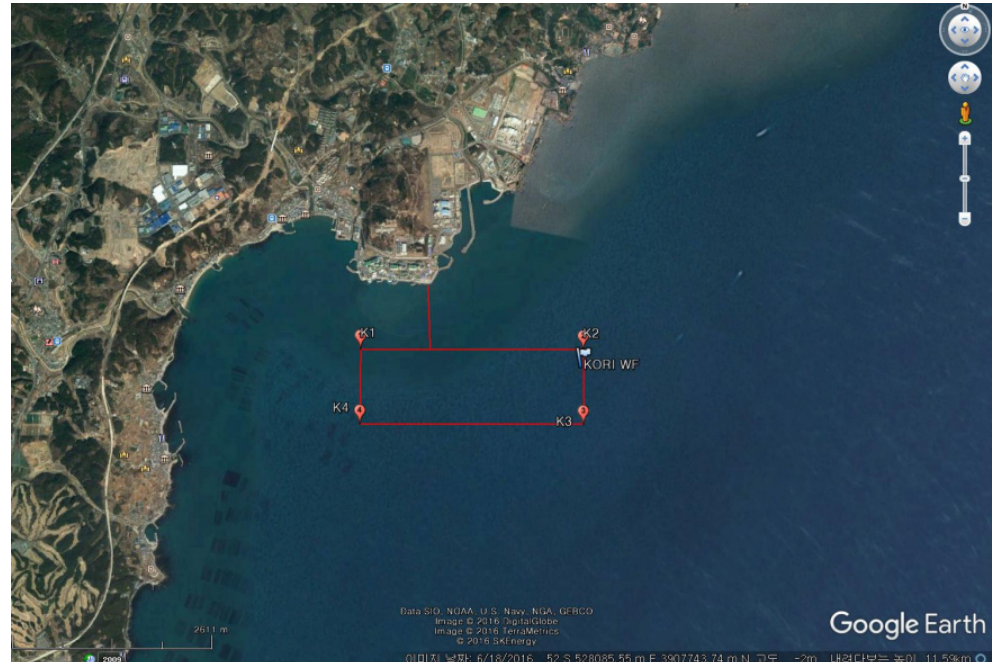
Figure 3. The Gori offshore wind farm location at East Sea of South Korea.